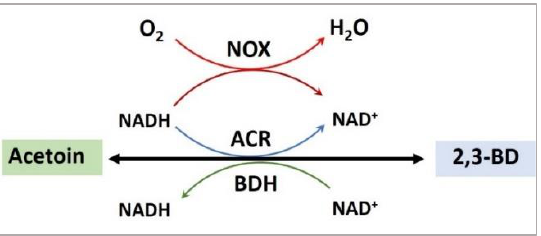
Figure 4. Enzymatic NAD regeneration system in microbial cell for the production of 2,3-BD and acetoin [5]. ACR: acetoin reductase; BDH: 2,3-butanediol dehydrogenase; NOX: NADH oxidase.